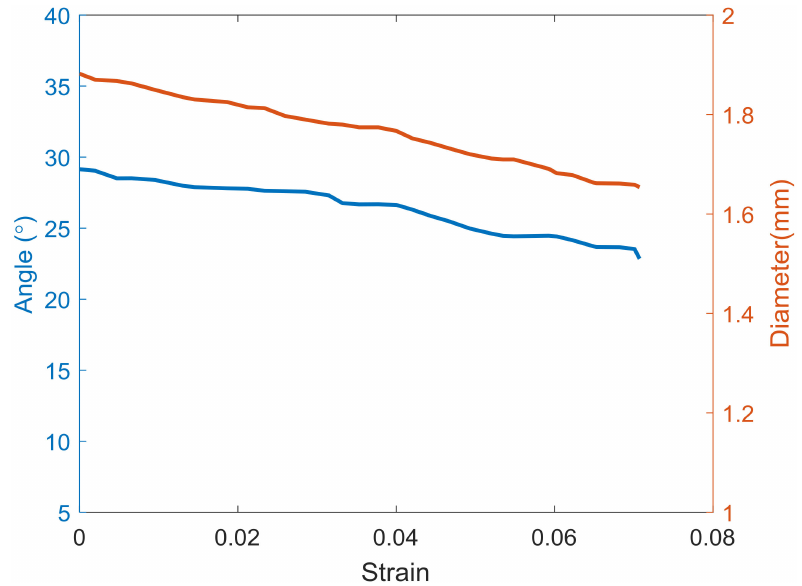
Figure 7. Change in angle and diameter of rope at the first cycle.